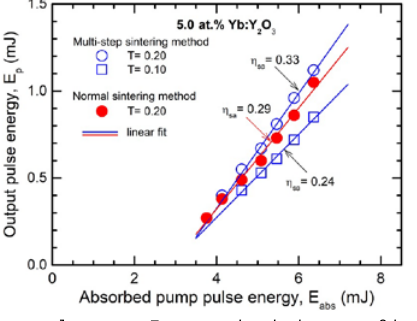
Fig. 1 Transmission spectra of the mirror-polished Fig. 2 Laser pulse energy, E 5.0 at.% Yb:Y 2 O 3 transparent ceramics. pulse energy, E abs . T: out-coupling mirror